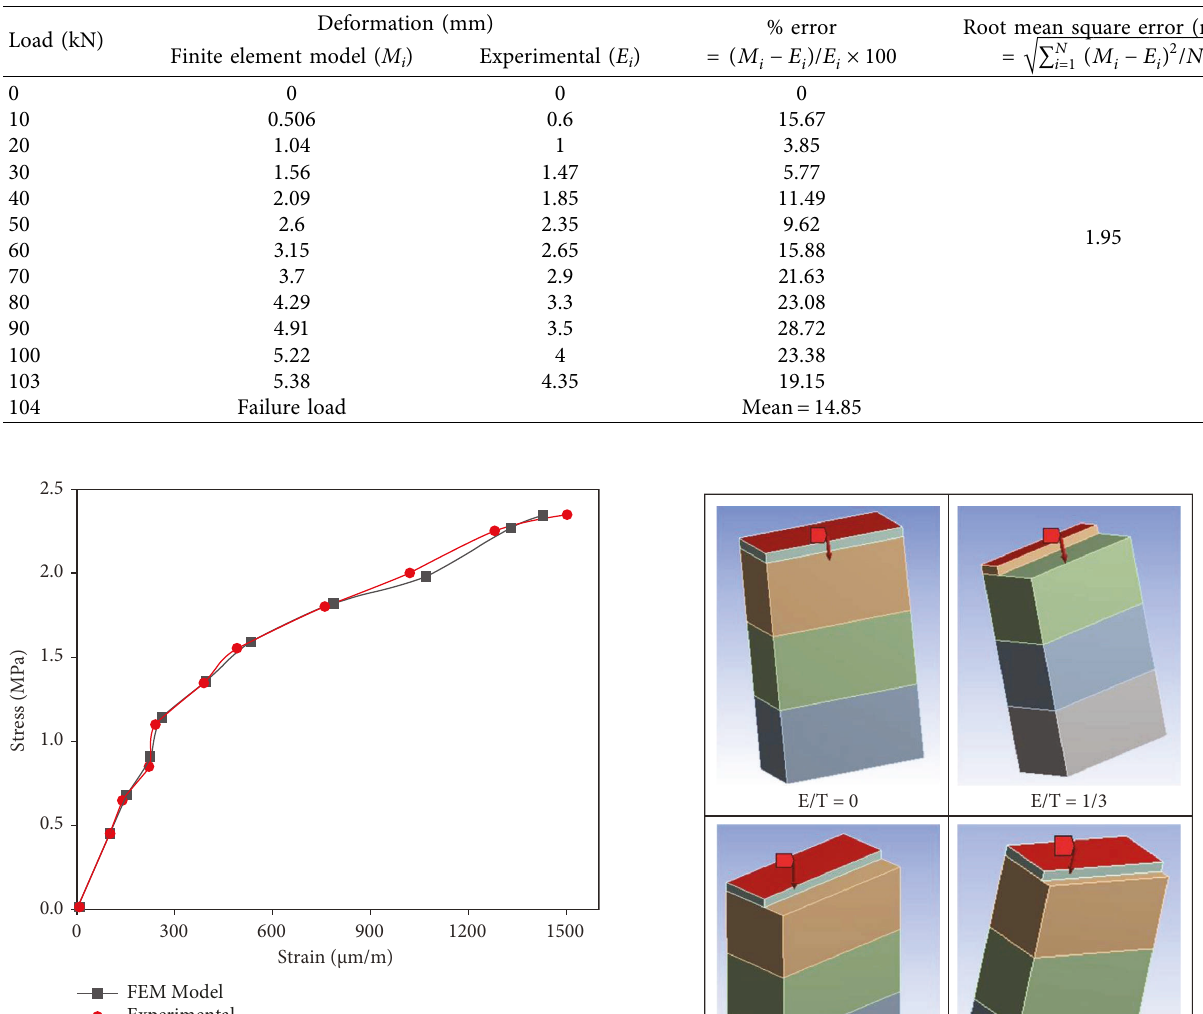
Table 2: Load-deformation values of CSRE prism (H/T � 3; E/T � 0).